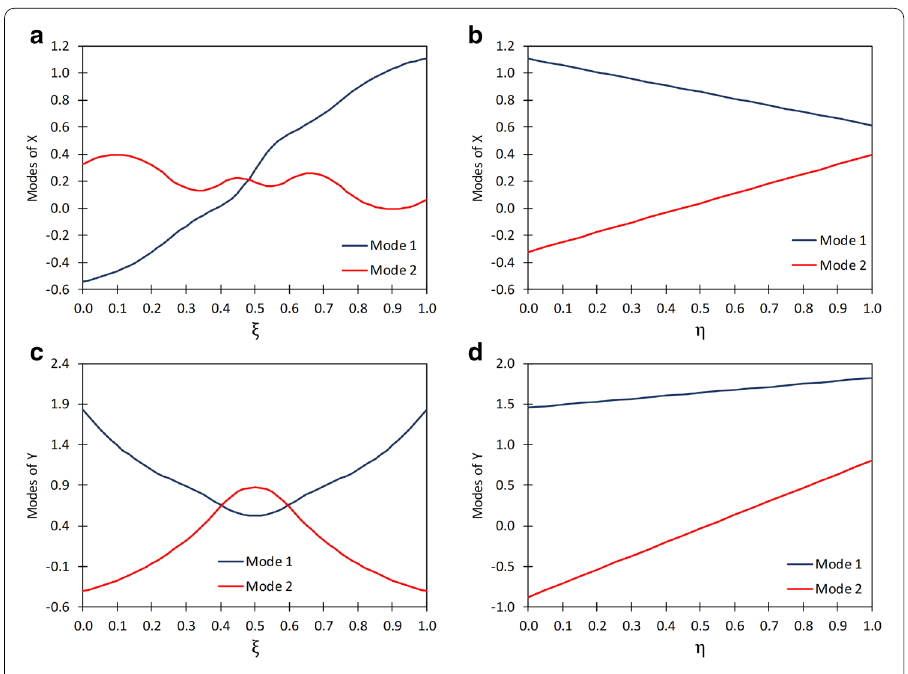
( ξ ) X 1 i ; b M T ( η ) X 2 i ; c M T ( ξ ) Y 1 i ; and 1 2 1